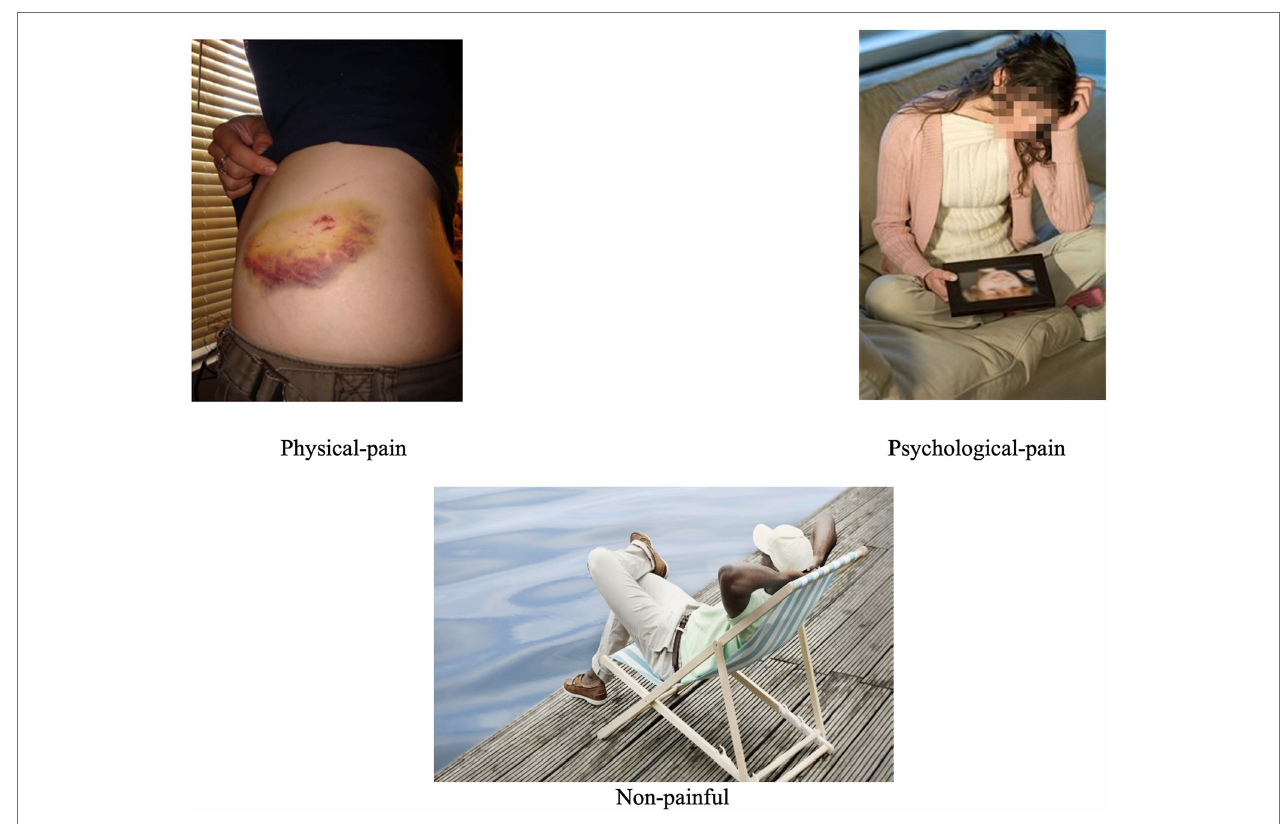
FIGURE 1 | Stimulus